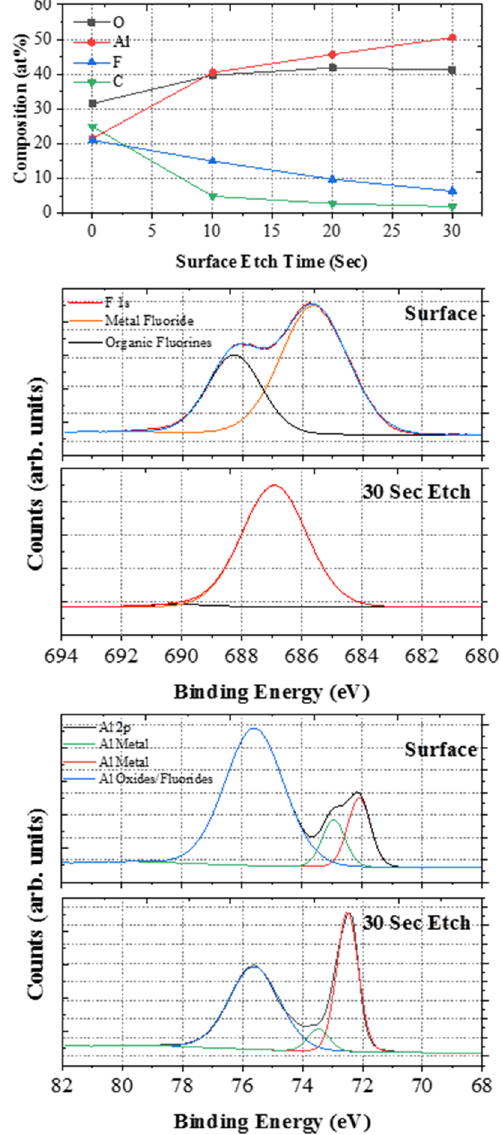
Figure 5. XPS analysis of aluminium electrodes after 15 min electron beam cleaning stage of top surface and after ion etching into subsurface for 10–30 s. Compositional analysis where fluorine contamination was observed on surface and into subsurface. High-resolution scans of F 1 s and Al 2p. Fluorine is present as Al–F and organic fluorine’s associated with a reaction between deposited Al and oil and remaining oil residue, respectively. Thirty-second etch showed only remaining Al–F. Al 2p spectra showed Al oxides and further support for presence of Al–F on surface and in subsurface. Al metal was also present, increasing in subsurface.